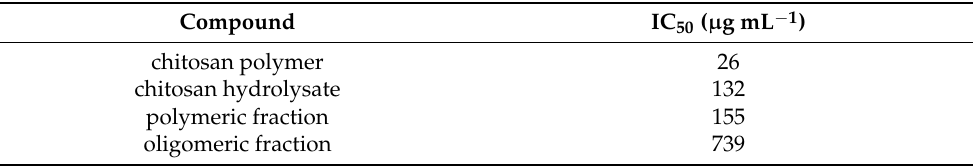
Figure 2. Antifungal activity against F. graminearum of ( A ) chitosan polymer ( F A 0.2, DP 347, Đ 2.2) and its chemical partial hydrolysate ( F A 0.2) and ( B ) the polymeric ( F A 0.2, DP 255, Đ 1.1) and oligomeric ( F A 0.2, DP 2-15) fractions of the hydrolysate. The IC 50 values were calculated via nonlinear regression analysis using GraphPad PRISM software, for details see Materials and Methods. Artificial data points required by the program to achieve sigmoidal curves are marked in grey. Data shown are mean values ± SD of at least three independent experiments consisting of six replicates each. Table 2. IC 50 values of the four chitosan samples against F. graminearum . Values are taken from the experiments shown in Figure